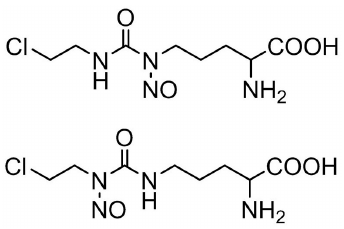
Figure 1. Structural formula of ormustine. Table 1. Solubility of ormustine substance in water and solutions of solubilizers.